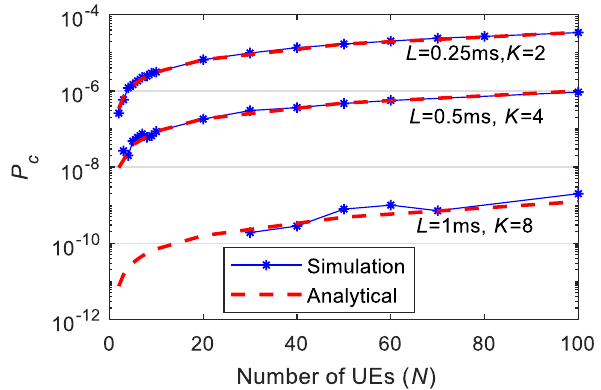
Figure 3. Comparison of analytical and simulation results for different latency requirements L and number of repetitions K ( U = 6, λ = 0.1 packets).